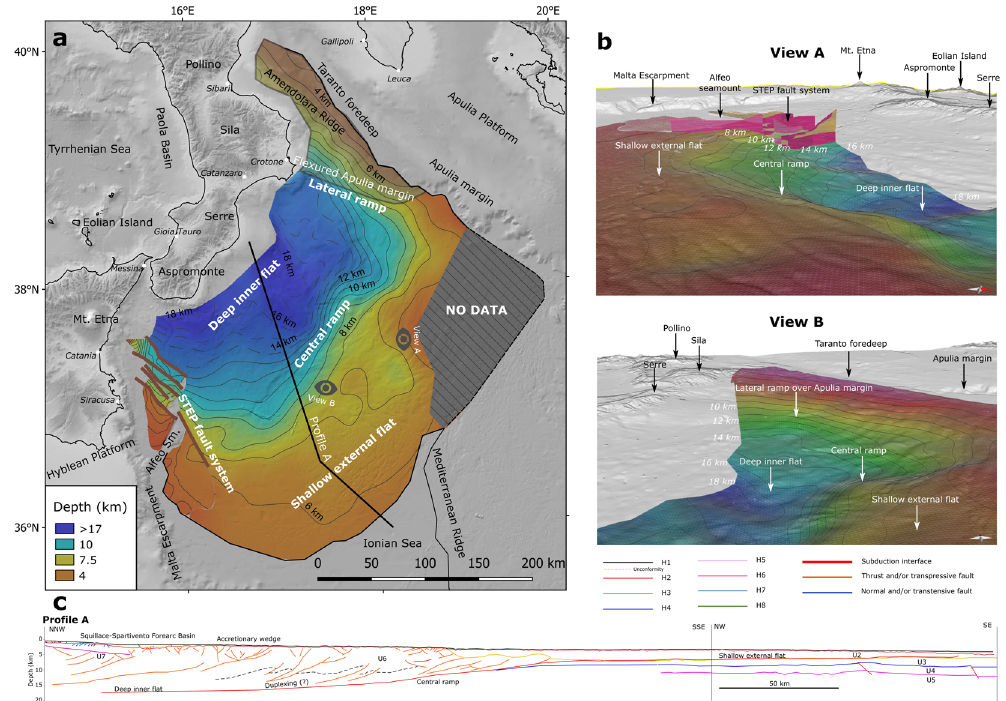
Figure 6. Depth-domain model of the shallow part of the subduction interface. Panel a – Gradient-colour map and depth contours (dashed where affected by larger uncertainty) of the shallow subduction interface (smoothing distance = 25 km), brown lines along the STEP fault system represents recent/active transtensional fault segments; Panel b – Perspective views of the subduction interface, viewpoints are indicated in Panel a. Panel c - Cross section (trace in Panel a) of the subduction interface and of the internal structure of the CAW from the interpretation and depth conversion of the seismic reflection profiles. Topo-bathymetric relief (Panels a and b) and profiles (Panel c) are obtained from SRTM30_PLUS 72 . Coastlines are from the European Environmental Agency